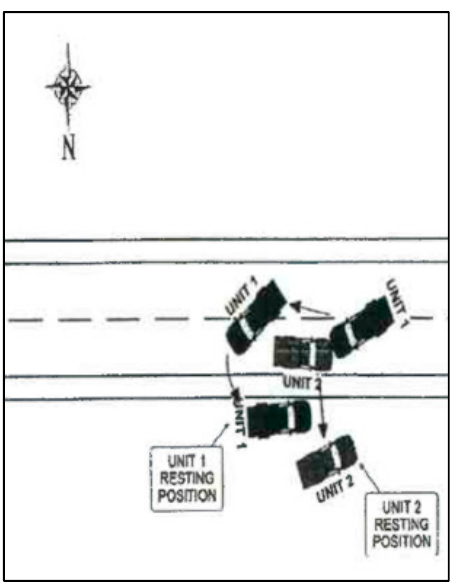
Figure 2. Police diagram of the crash. The decedent’s Chevrolet is “Unit 1”.